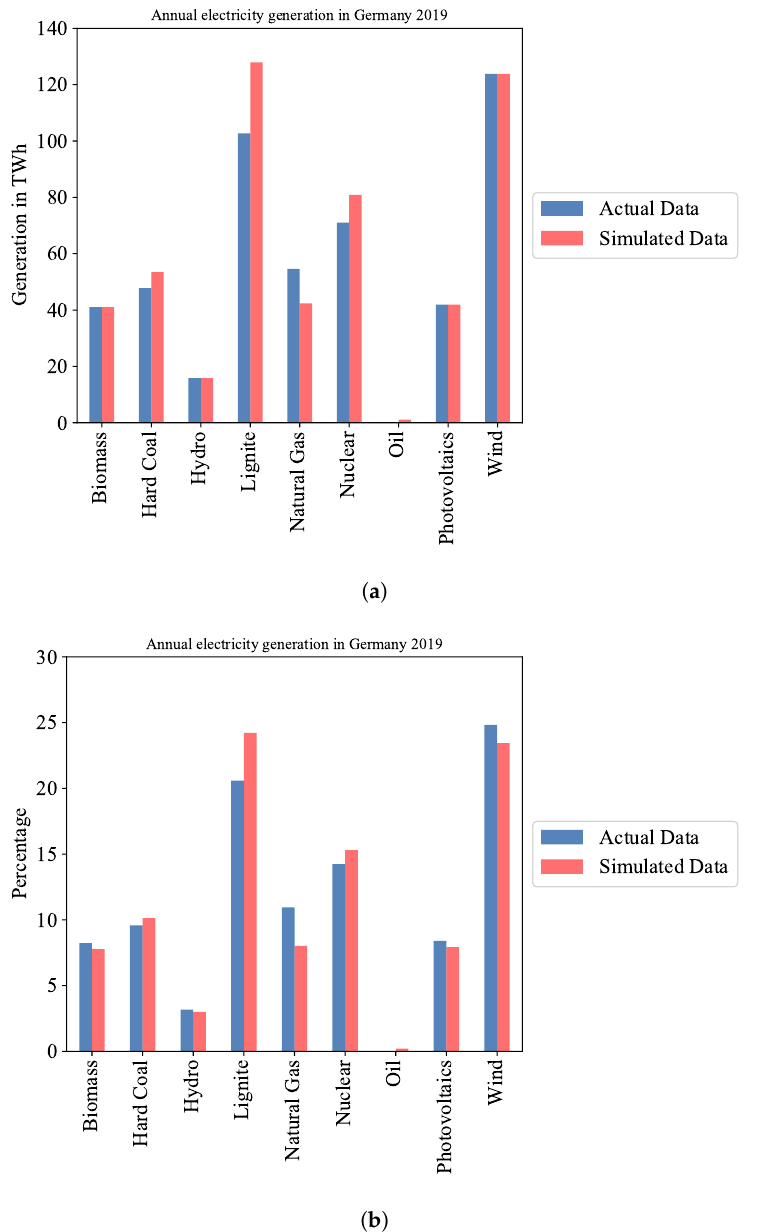
Figure 8. Comparison of simulated annual electricity generation per type and historical data as reported by ENTSO-E [48] obtained from SMARD [49]. ( a ) Total generation in TWh; ( b ) Total generation in